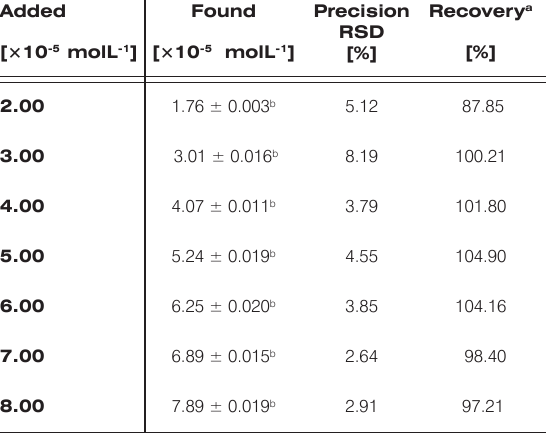
= 60 mV, sw Table 2. Accuracy and precision obtained by SW